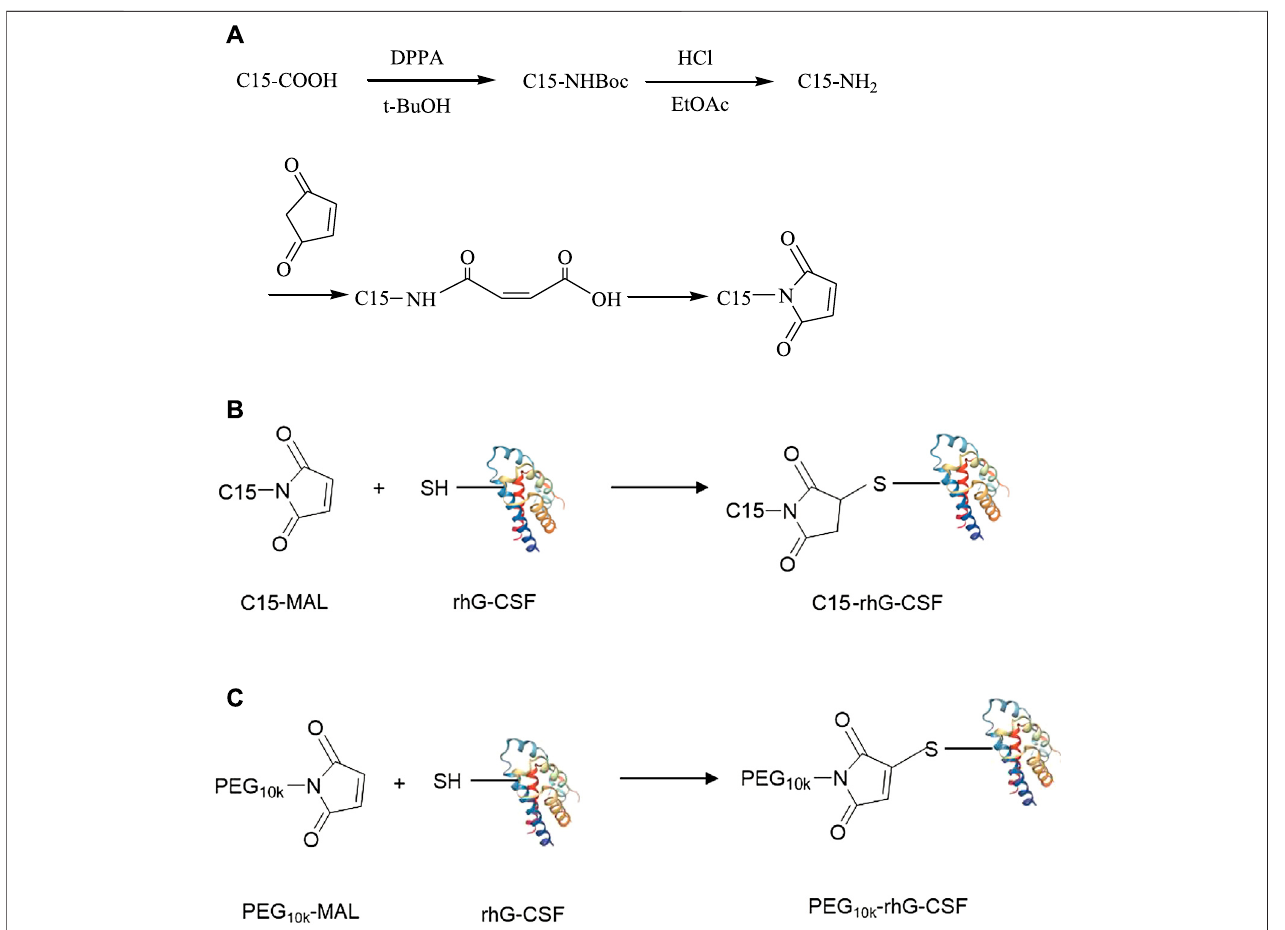
FIGURE 1 | The synthetic routes of C15-MAL (A) , C15-rhG-CSF (B) and PEG 10k -rhG-CSF (C) .